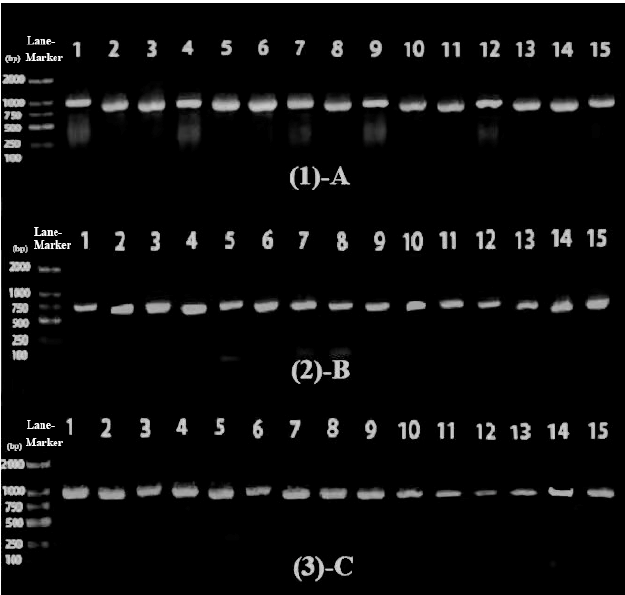
Figure 7. Lanes (1), (2), and (3) represent the cDNA amplification products, respectively, obtained by amplification with primers A, B, and C; from left to right: the D1, D2, D3, D4, D5, D6, D7, D8, D9, D10, D11, D12, D13, D14, and D15 species.